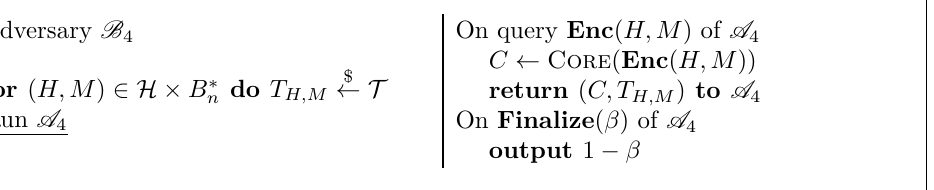
Figure 10: Adversary B 4 for the proof of Theorem